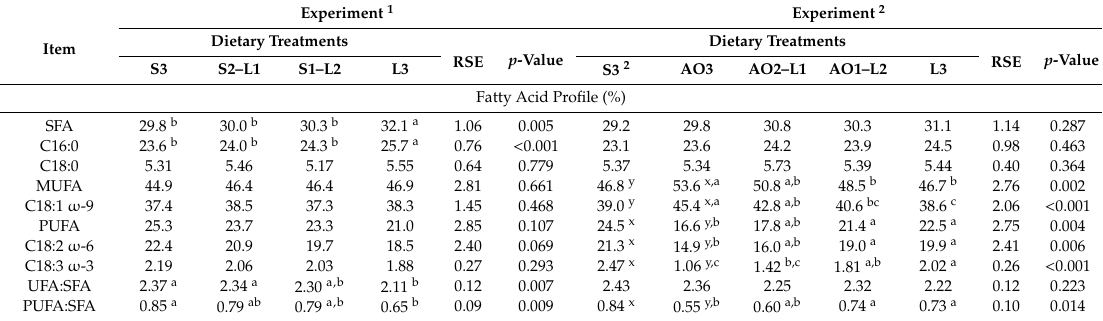
Table 9. Fatty acid composition of abdominal fat pad of broiler chickens according to di ff erent fat sources 1 in diet (Experiments 1 and